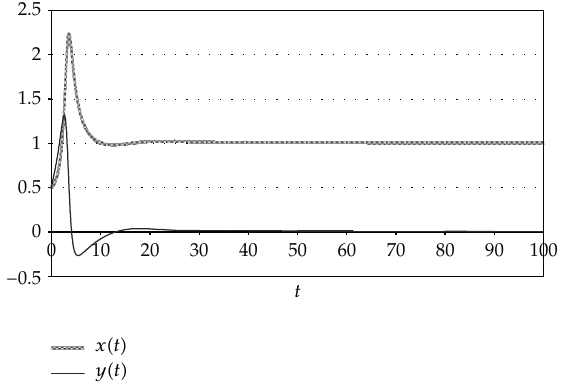
Figure 9: x (cid:2) 0 (cid:3) (cid:6) 0.5, y (cid:2) 0 (cid:3) (cid:6) 0.5, a (cid:6) 0.1, b (cid:6) 0.4, alpha (cid:6)